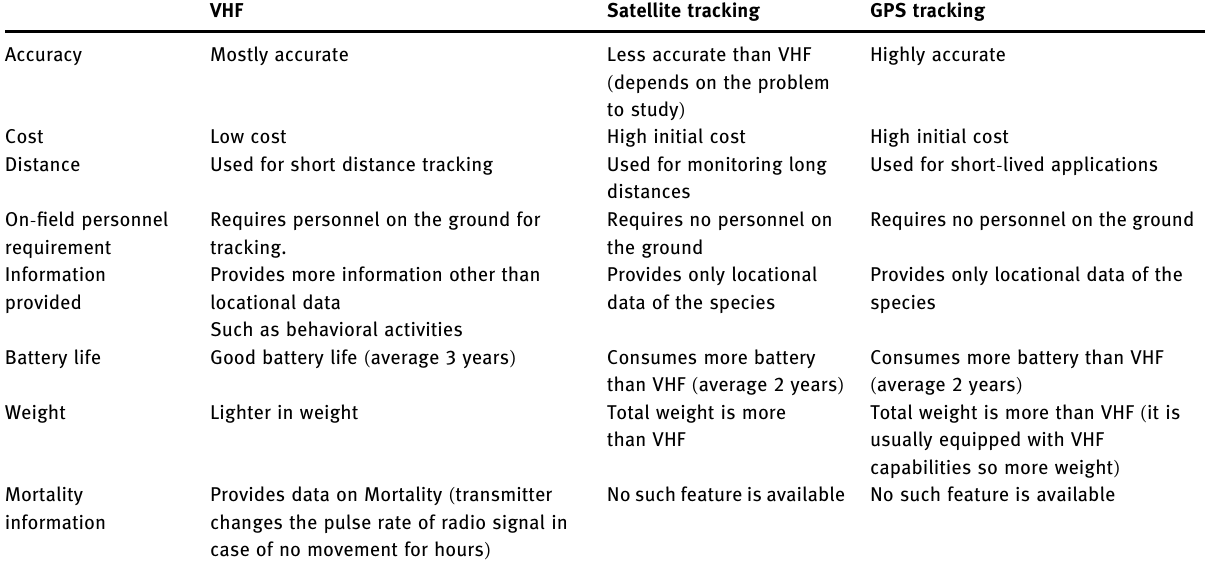
Table 3: Comparison of radio - tracking/radio collars for tigers